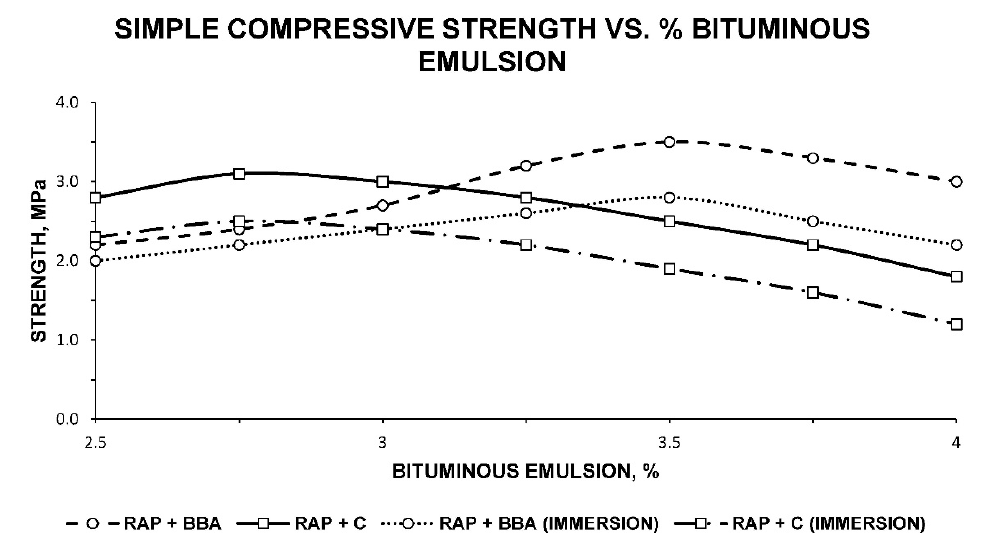
Figure 10. Graph of the results of the simple compressive strength test with and without immersion, standard NLT-162/00, for bituminous mixtures made with RAP and BBA (RAP + BBA), as well as for bituminous mixtures with RAP and limestone aggregate (RAP + C).